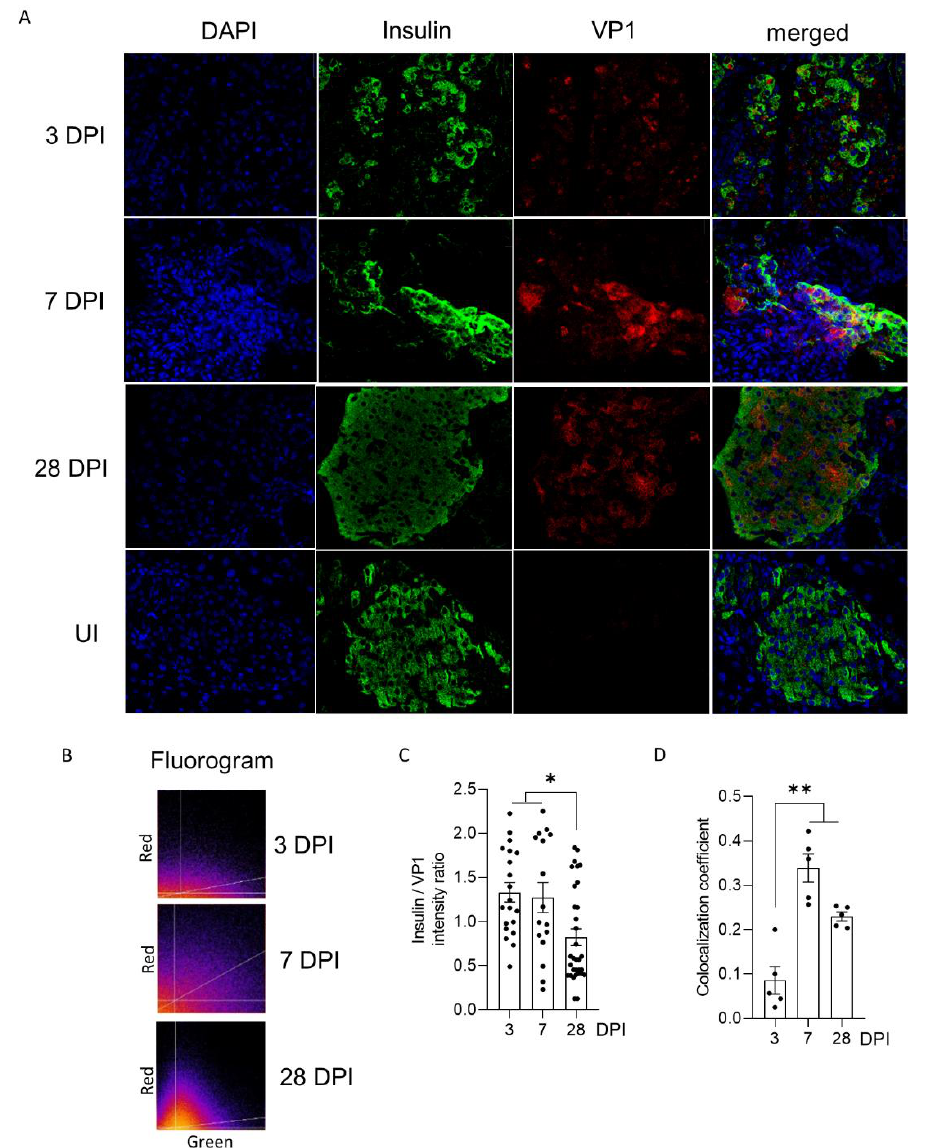
Figure 3. Impact of CVB3/28 infection on the insulin content of pancreatic islet cells of DBA/2J mice. ( A ) An immunofluorescence assay was performed using monoclonal antibody for CVB3/28 VP1 and insulin in thin sections of the pancreas, from 3 to 28 days post-infection (DPI), and from uninfected mice (original magnification: × 200). ( B ) On the fluorograms, green intensities are plotted on the x-axis, and red intensities are plotted on the y -axis. The white lines in both plots represent threshold levels applied to both channels for subsequent analysis of the volume. The third line represents a correlation curve using colocalization analyses with JACop. All pixels above and on the right are possible colocalized points. ( C ) Insulin/VP1 intensity ratio was measured for cells positive for insulin from 3, 7 and 28 DPI ( n = 20, 16 and 32 regions of interest (ROIs) respectively). ( D ) Colocalization coefficient (Pearson) was calculated using QuPath from 3 to 28 DPI in 1 to 3 islets per slice ( n = 5, each dot represents an islet), from 3 to 28 DPI. The results shown are representative of 3 mice at each indicated time point. ROIs (were chosen within the positive cells for insulin, and colocalization was monitored with the JACoP plugin of ImageJ (manual thresholding). Data represent mean +/ − SEM. Mann-Whitney Test. *: p < 0.05; **: p < 0.01. VP1: viral protein 1. UI: uninfected. DPI: days